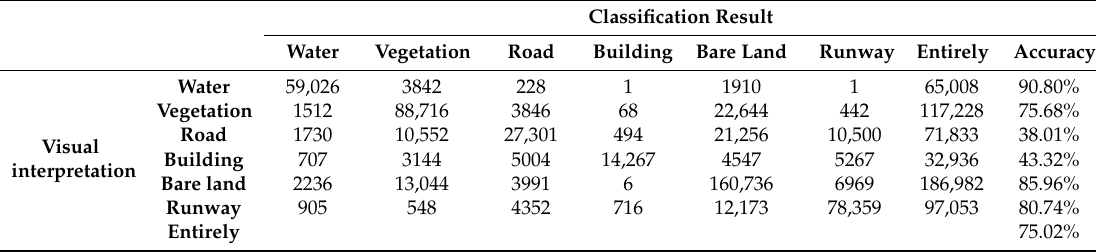
Table 6. Confusion matrix of standard false color image classification results in Pudong International Airport.